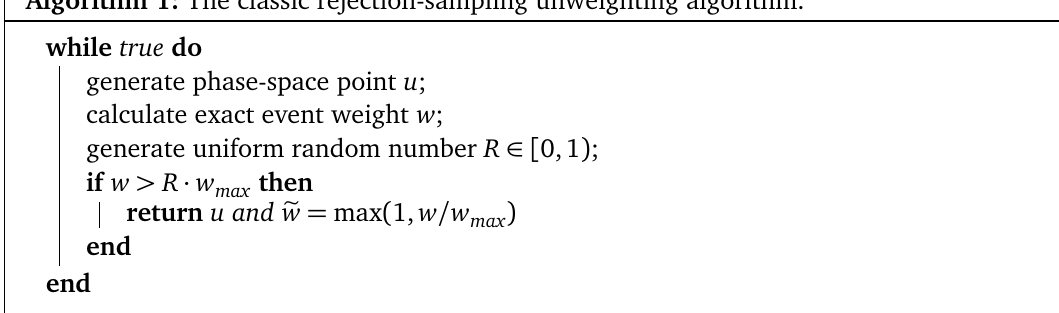
Algorithm 1: The classic rejection-sampling unweighting